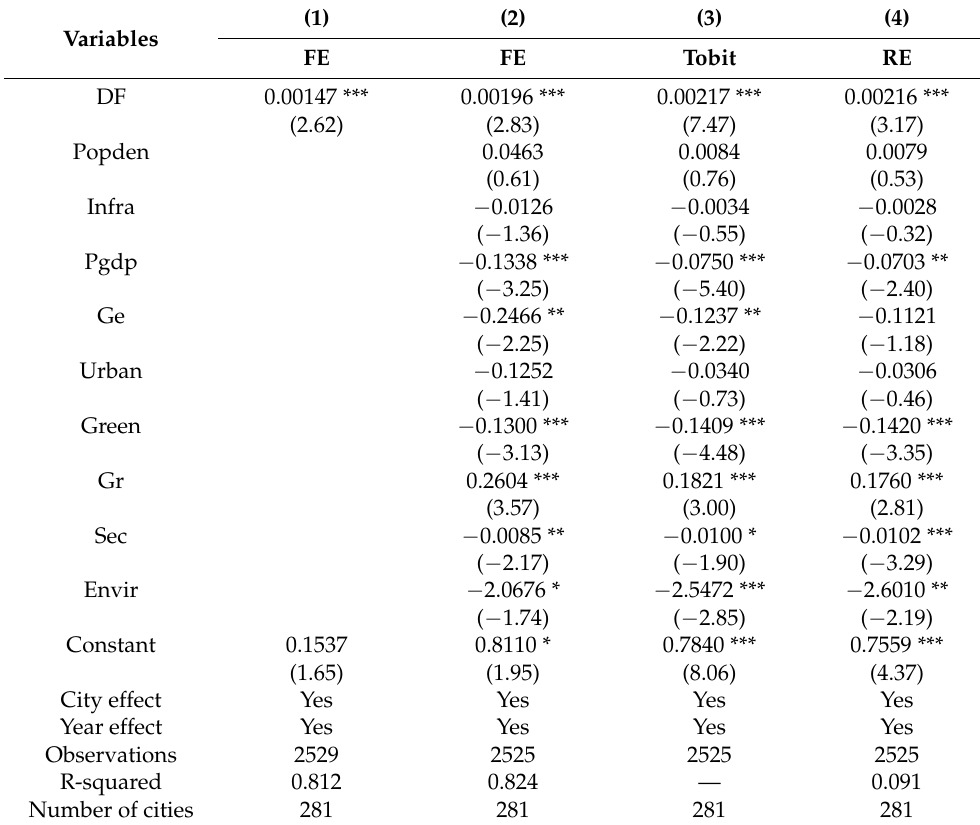
Table 3. Estimate results of the benchmark model.